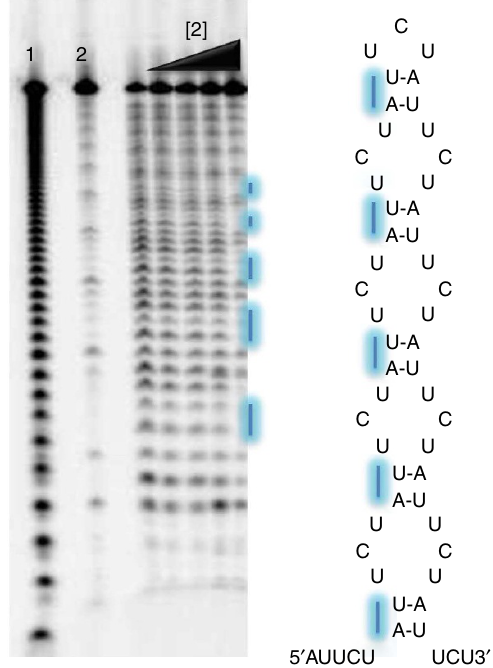
Figure 5 | Compound 2 protects r(AUUCU) 11 from cleavage by RNase V1. Left, representative gel image of the RNase protection assay. Lane 1, alkaline hydrolysis of r(AUUCU) 11 ; lane 2, r(AUUCU) 11 þ No RNase V1; lanes 3–7, r(AUUCU) 11 þ RNase V1 þ 2 (0, 0.02, 0.2, 2 and 20 m M). Lines indicate sites of protection. Right, secondary structure of r(AUUCU) 11 . Protected nucleotides are indicated with blue lines.